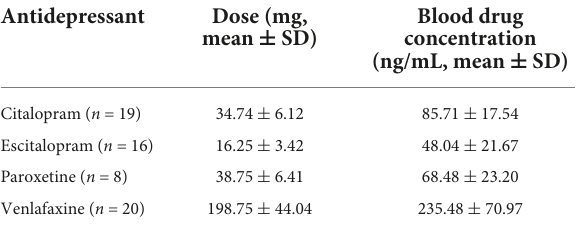
HAMD,HamiltonDepressionRatingScale;HAMA,HamiltonAnxietyRatingScale;NA,notapplicable;MDD,majordepressivedisorder;HCs,healthycontrols;SD,standarddeviation; BMI,bodymassindex.